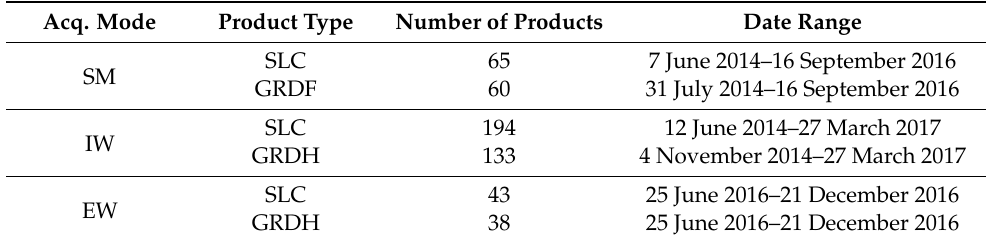
Table 1. Number and types of Sentinel-1 (S-1) products used for absolute location error (ALE)